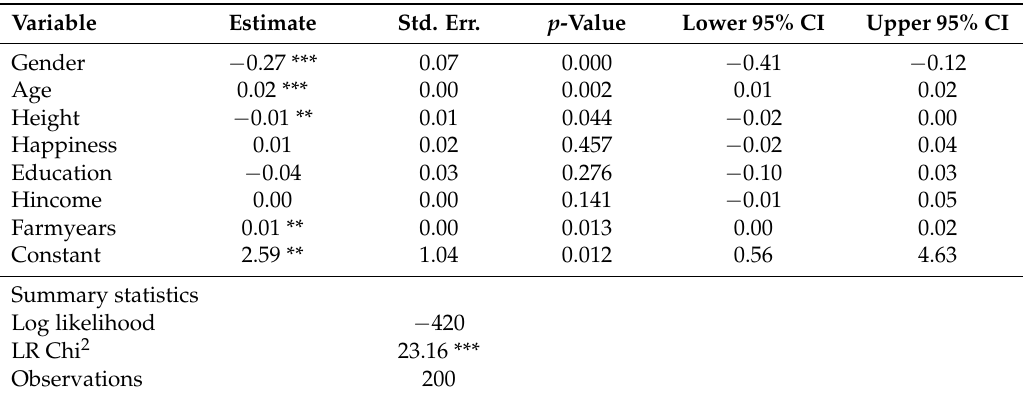
Table 5. Multivariate correlates of the experiment.